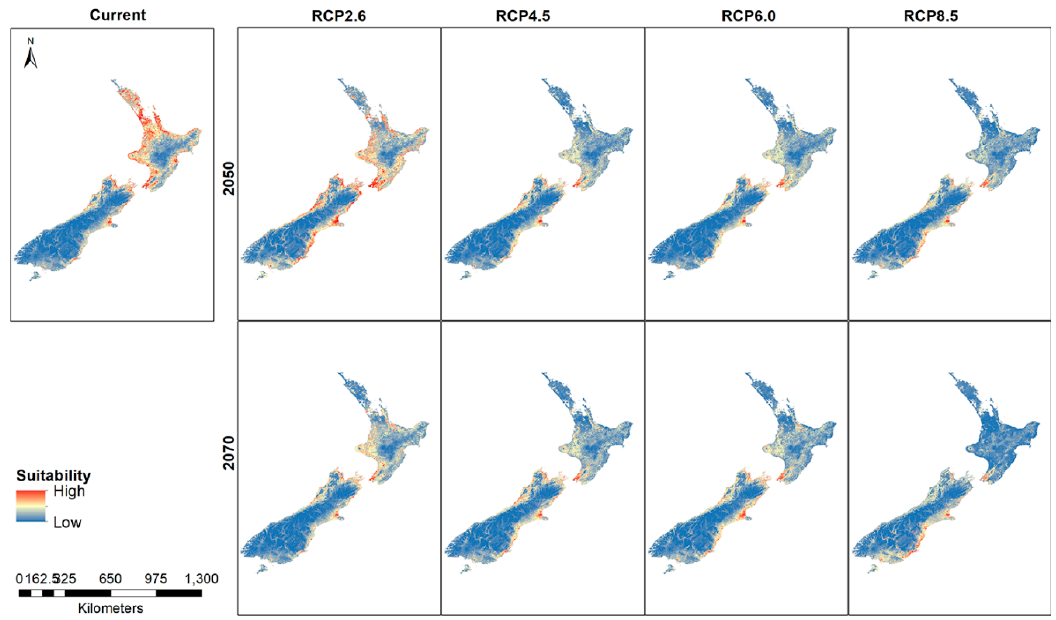
Figure 5. New Zealand suitability for the Mexican daisy under different climate scenarios and years. Thresholded rasters show small differences between the current model and the future distribution (Figure 6). A noticeable change in the predicted presence areas is found in the higher emission RCP8.5 for 2070 where large areas of North Island show a greater absence prediction compared to the rest of the thresholded maps. The RCP4.5 and RCP6.0 maps show greater predicted absence areas compared to the current habitat suitability map.